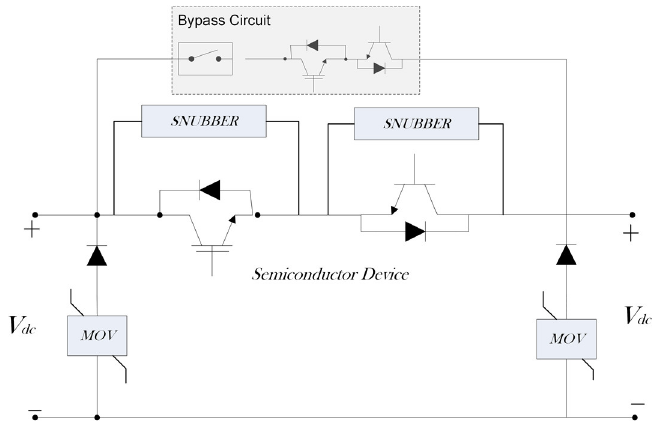
Figure 15. Hybrid Circuit Breaker [82].